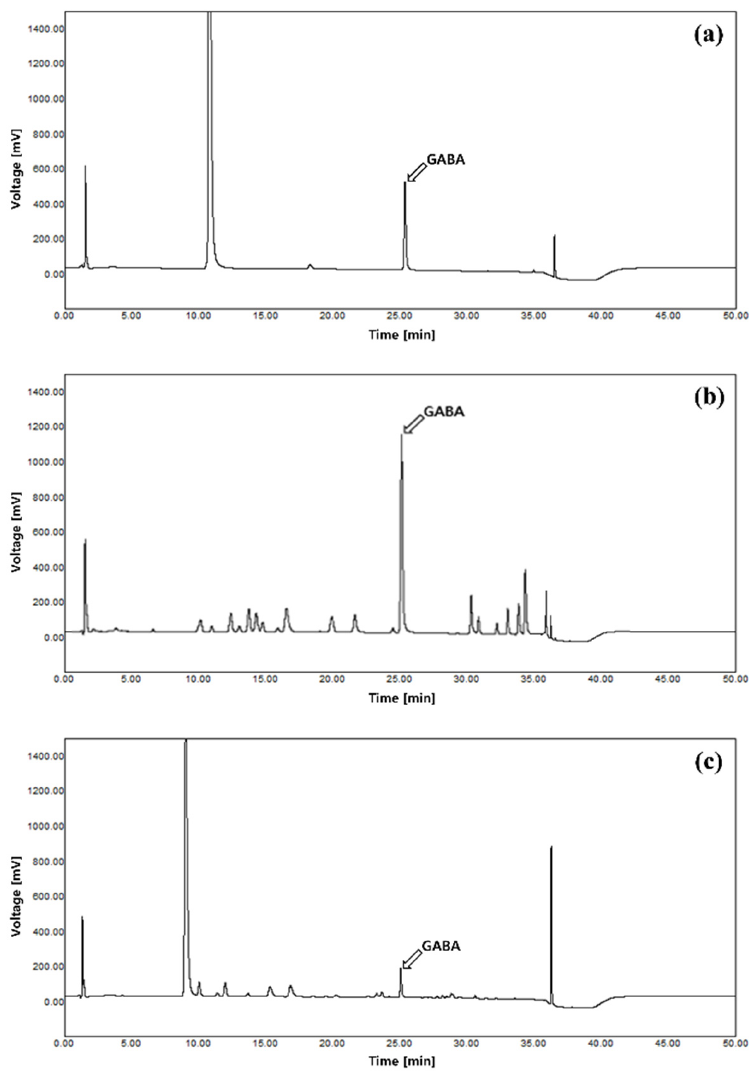
Figure 2. Typical HPLC chromatograms of GABA in ( a ) standard solution, ( b ) bacterial culture, and ( c ) LFG.